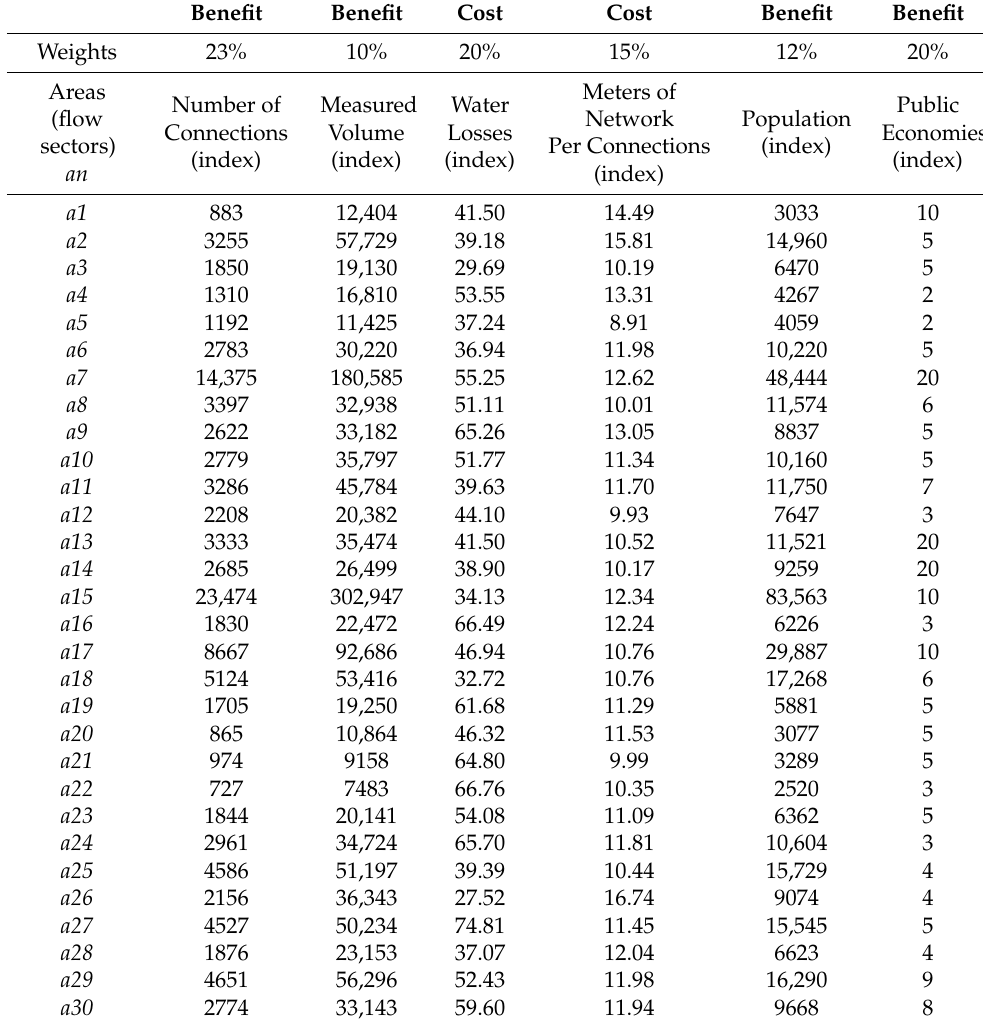
Table 4. Original dataset.